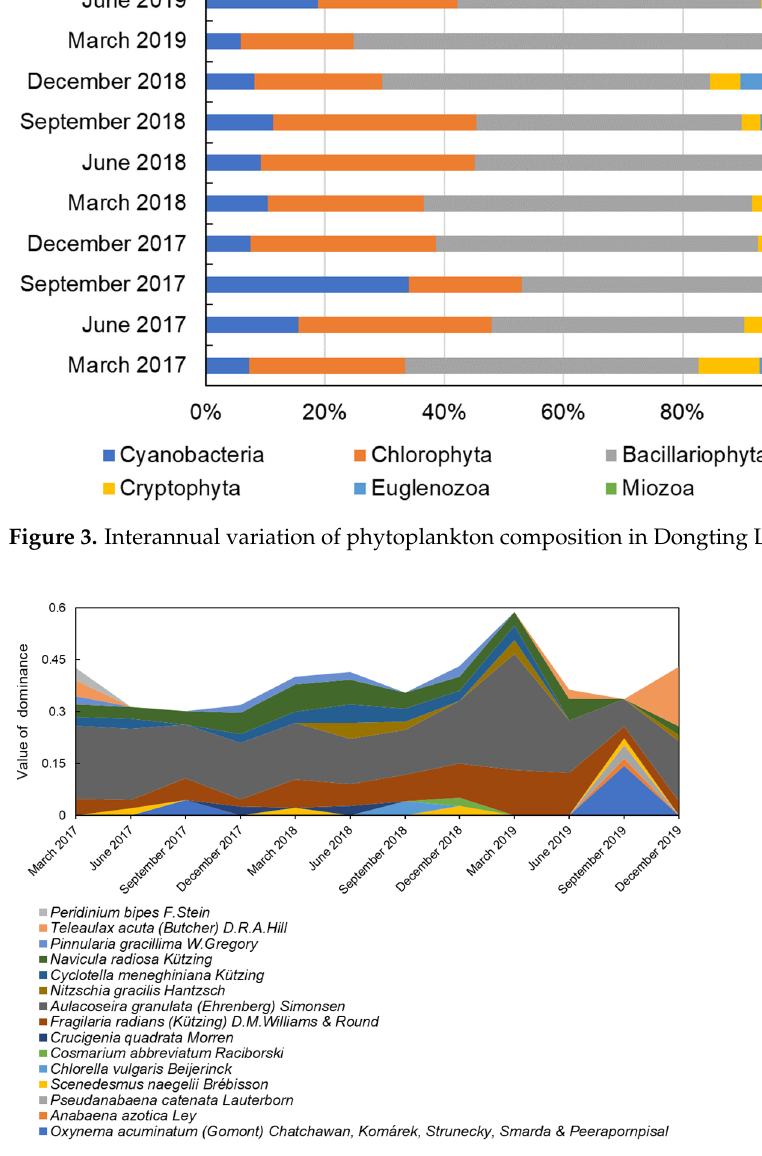
Figure 3. Interannual variation of phytoplankton composition in Dongting Lake.